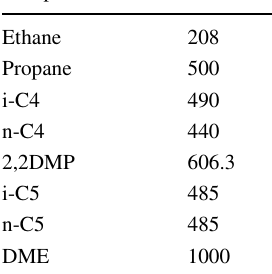
Table 2 LPG components